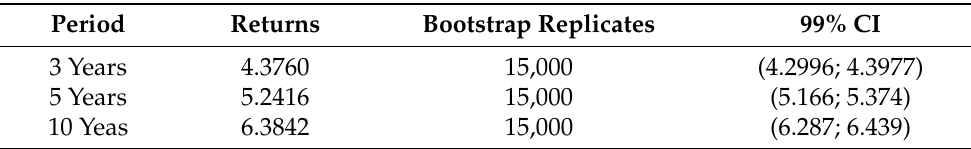
Table 9. Shows return level periods and posterior distribution with 99% uncertainty interval boot- straps forecasts for VaR and